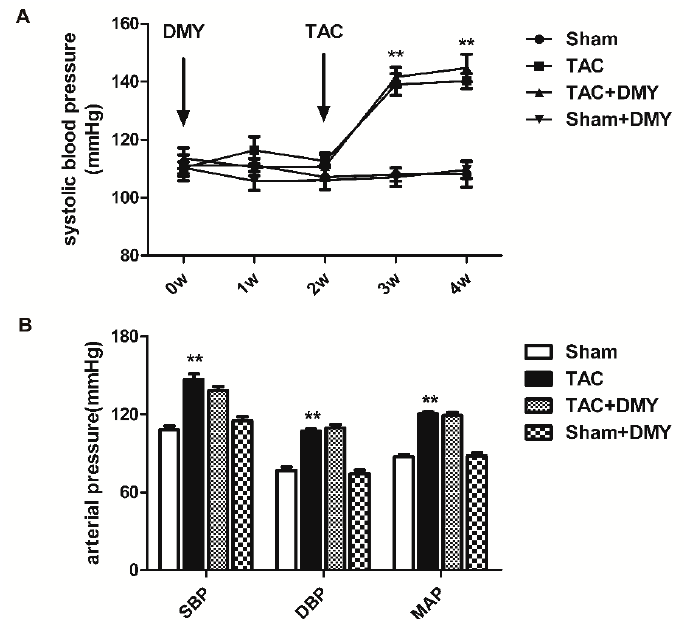
Figure 2 . Effect of DMY on blood pressure in mice after transverse aortic constriction (TAC). Male Figure 2. Effect of DMY on blood pressure in mice after transverse aortic constriction